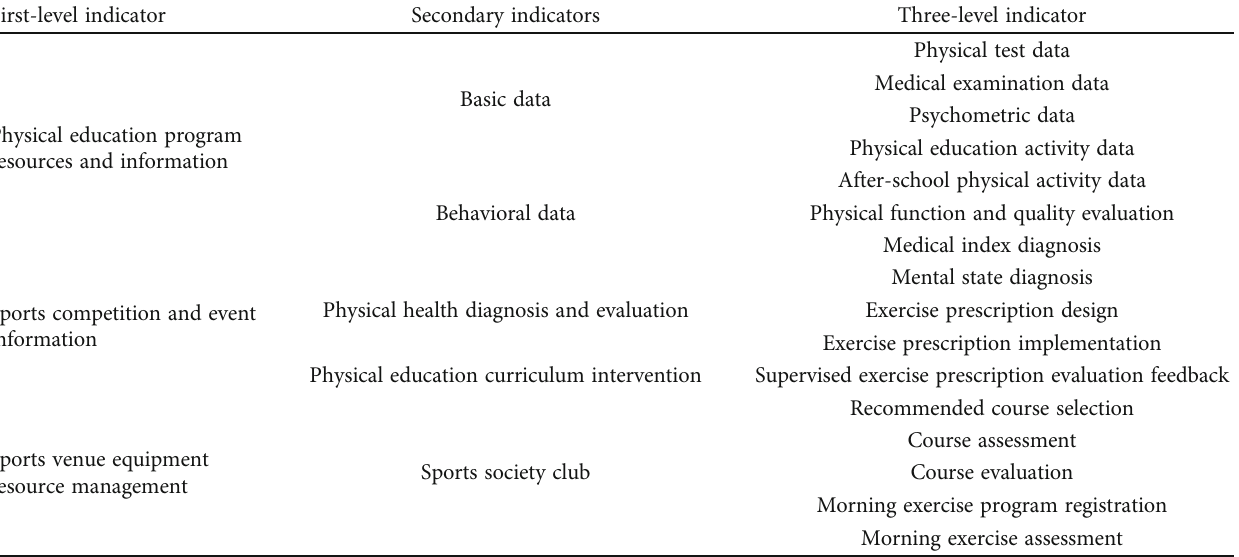
Table 1: Functional module screening table of the physical health test data platform for students in colleges and universities.